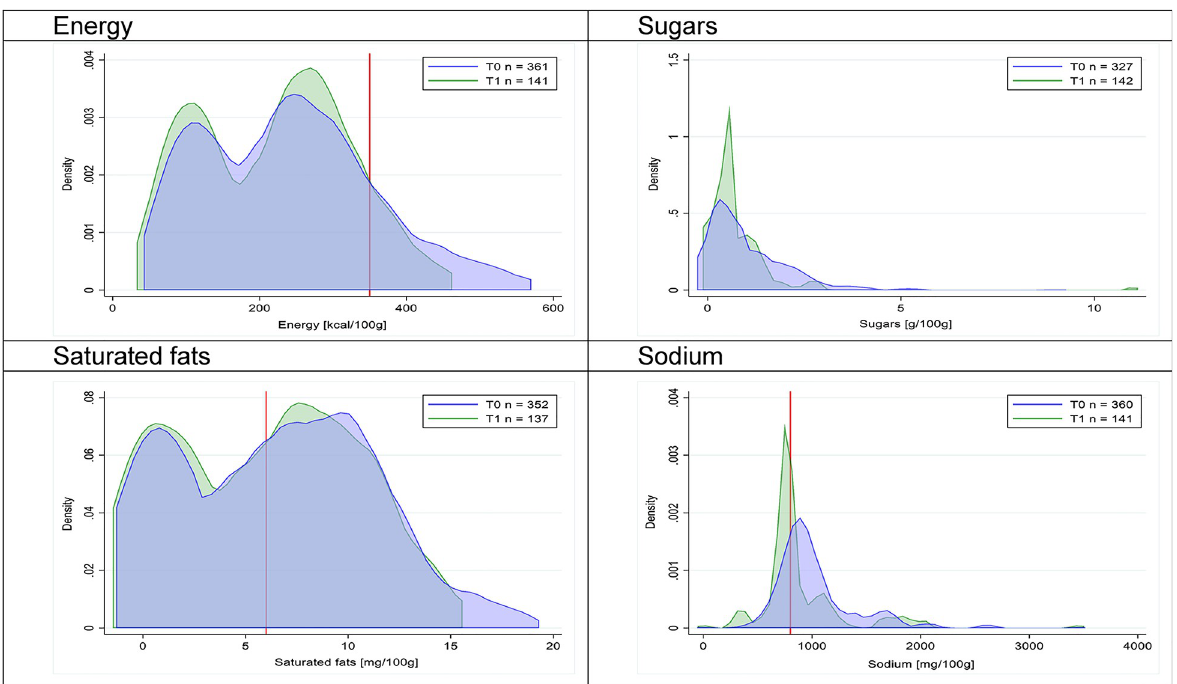
Fig 15. Density curves for the amount of energy and nutrients of concern in sausages, cross-sectional samples. The blue line represents the distribution in T0 (preimplementation), the green line represents the distribution in T1 (postimplementation), and the red line represents the cutoff for the amount of energy or nutrients of concern.